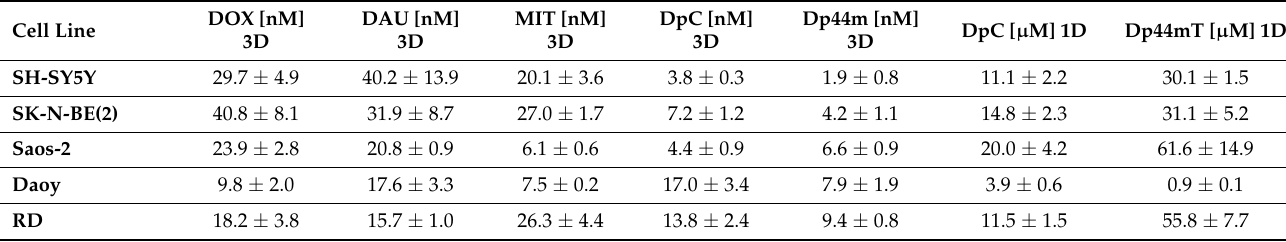
Table 1. IC 50 values used for subsequent